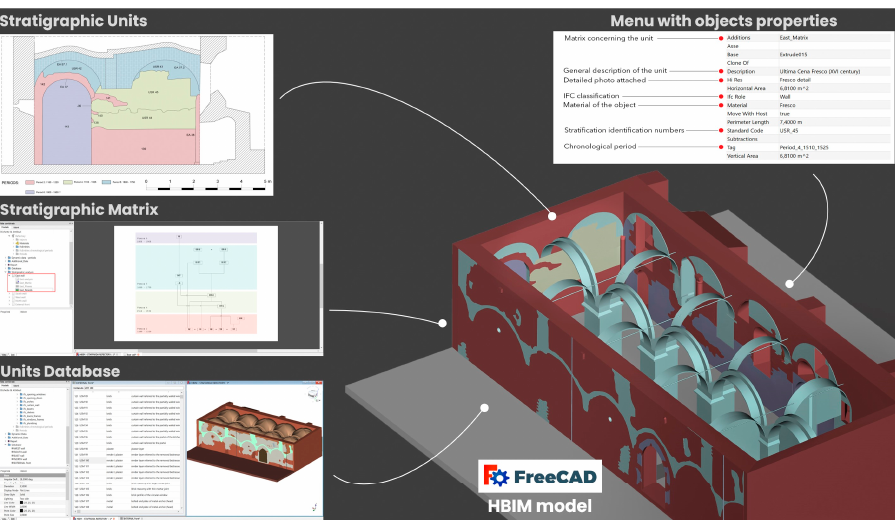
Figure 9. Stratigraphic units and analysis implemented inside the HBIM model of the refectory: stratigraphy and interpretation as parametric objects, database, semantic data and